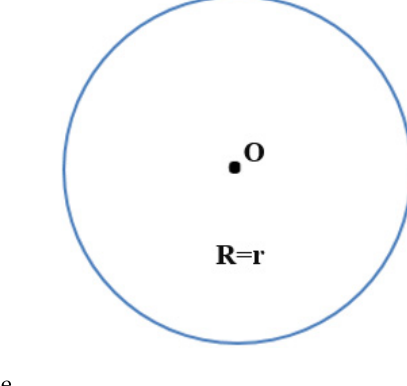
Figure 5. Modeling of sphere-like soil particle.